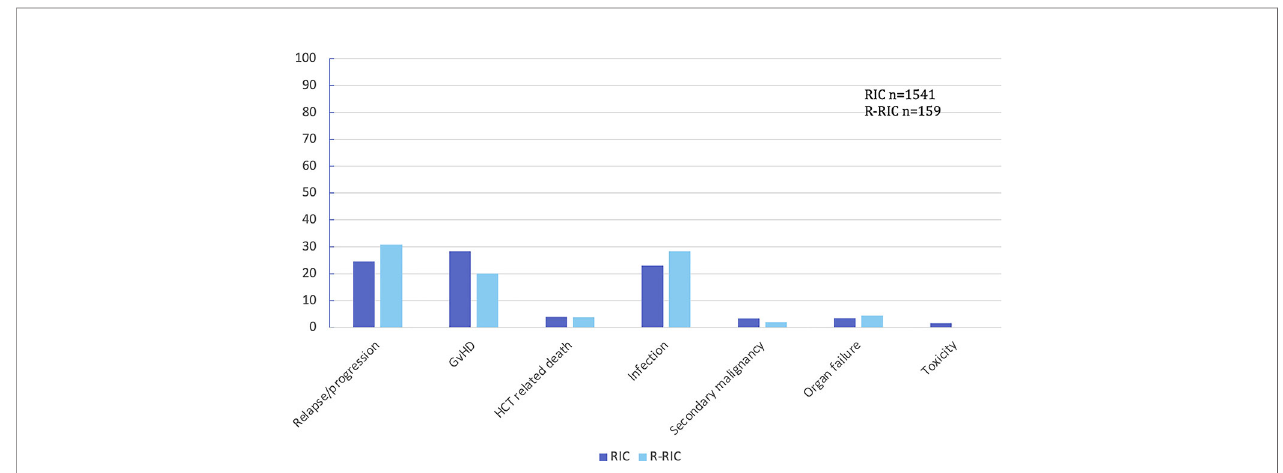
FIGURE 1 | Main causes (percentages) of death in patients ’ cohorts: RIC vs R-RIC. GvHD, graft versus host disease; HCT, hematopoietic cell